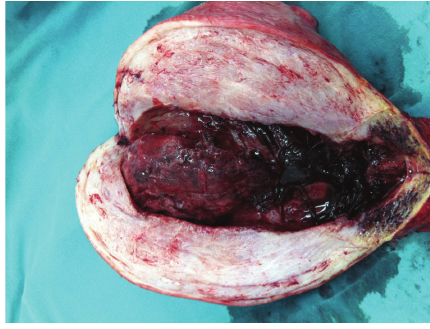
Figure 1: Macroscopy of uterus (hysterectomy material).